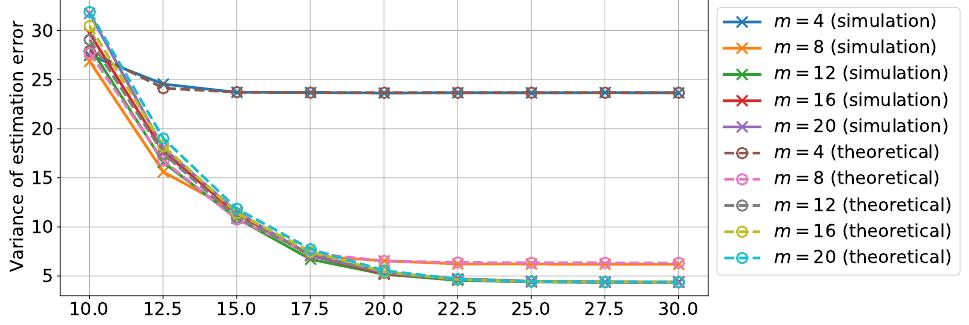
Figure 2. Theoretical and simulated variance of estimation error on the position depending on the energy supplied to each variable using an unreliable memory for different numbers of bits in the representation m .